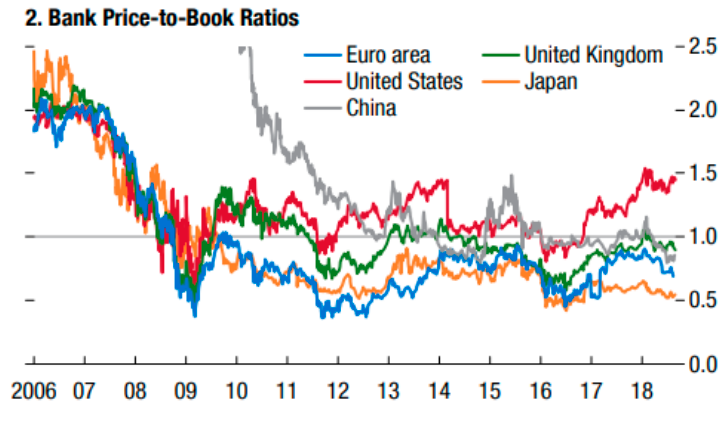
Figure 1. Bank price-to-book ratios.